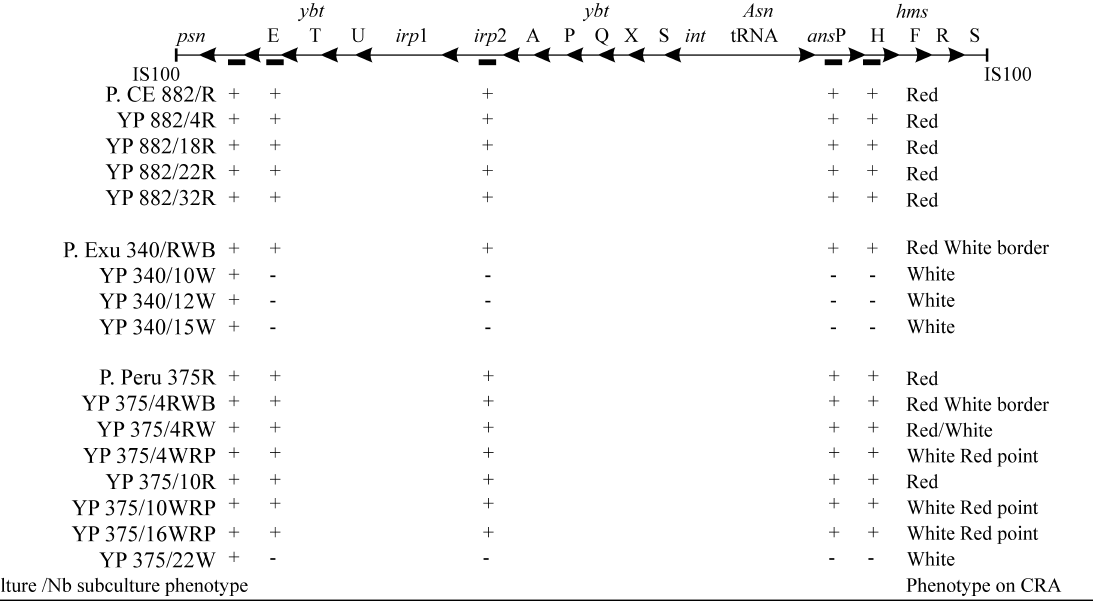
Figure 1 - Schematic representation of the pgm locus of Yersinia pestis showing the results of PCR amplification of segments located in the high-pathogenicity island (HPI) and in the pigmentation segment of the different strains. The bars below the pgm locus represent the targeted genes. (+) = presence of the amplified DNA segment; (-) = no amplified